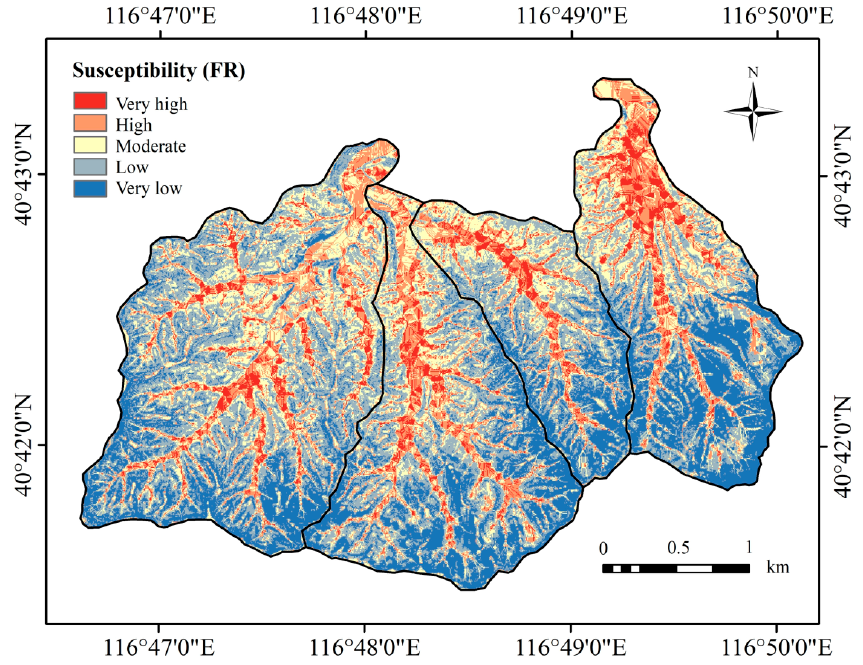
Figure 7. Mass-wasting susceptibility map generated by using the frequency ratio model.